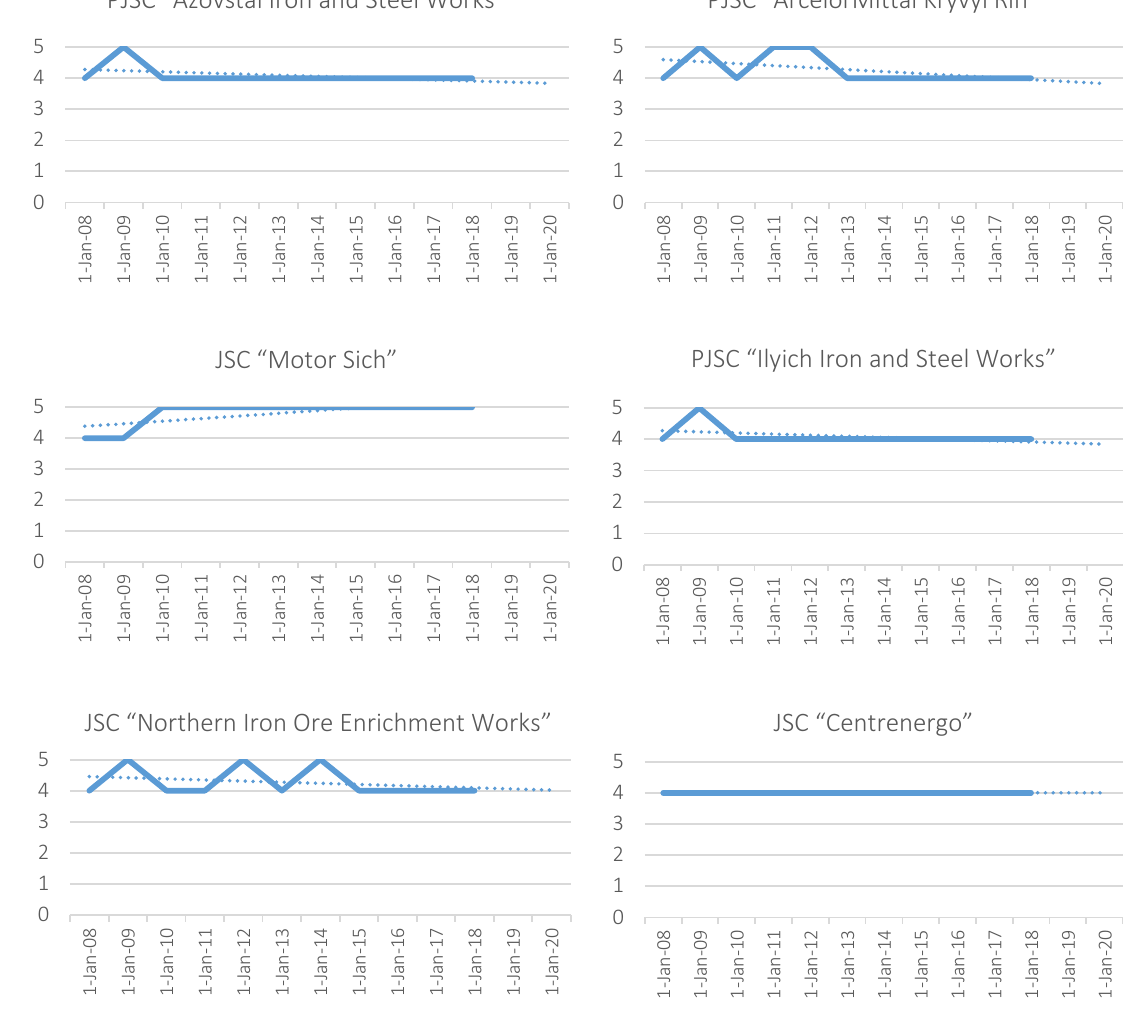
Figure 3. Group of the most Ukrainian stable companies (within the relevant